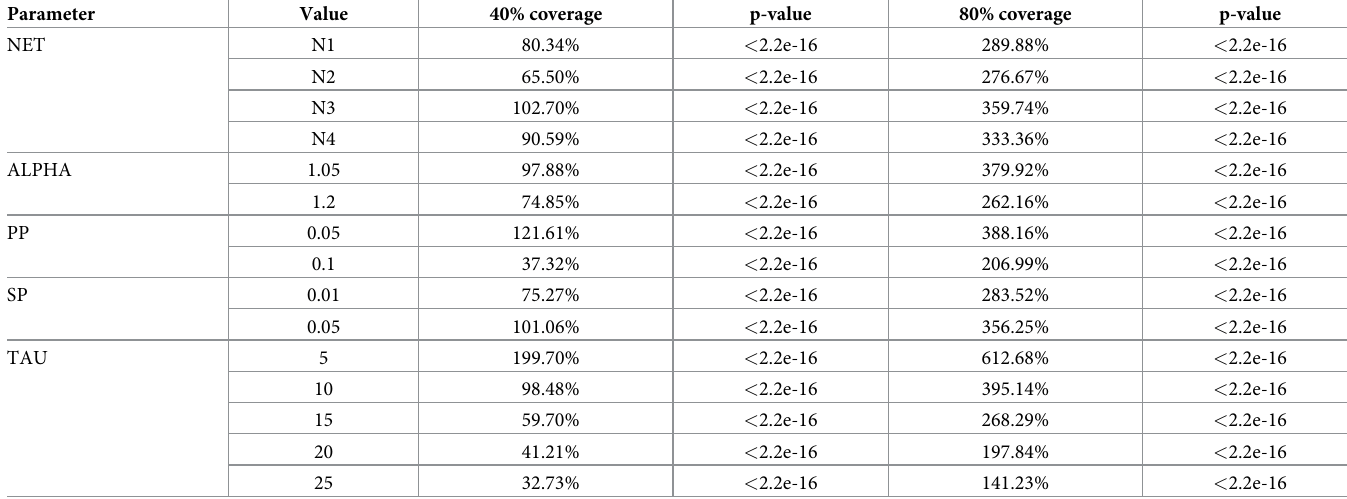
Table 6. Duration increase for spreading processes with the habituation effect.